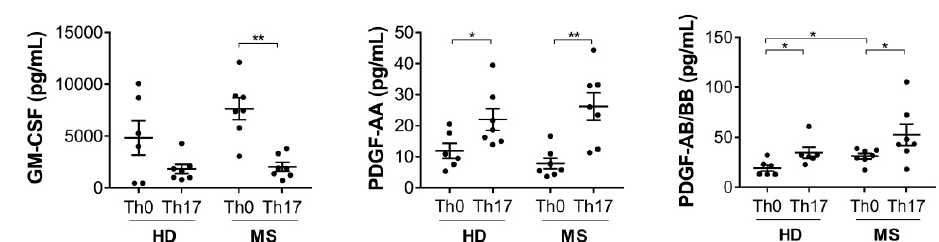
Figure 2. Production of cytokines involved in inflammation and T cell activation are increased in Th17 cells from MS patients. Naive CD4 T cells from healthy donors (HD) and multiple sclerosis (MS) patients were cultured with antiCD3-antiCD28 alone (Th0) or antiCD3-antiCD28 + TGF- β , IL-6, IL-23 and IL-1 β (Th17). At 5 days of differentiation the levels of inflammatory cytokines ( A ), cytokines involved in T cell expansion ( B ), and growth factors ( C ) were analysed by multiplex assay (Luminex) in cell supernatants (* p < 0.05; ** p < 0.01; *** p < 0.001; **** p < 0.0001).